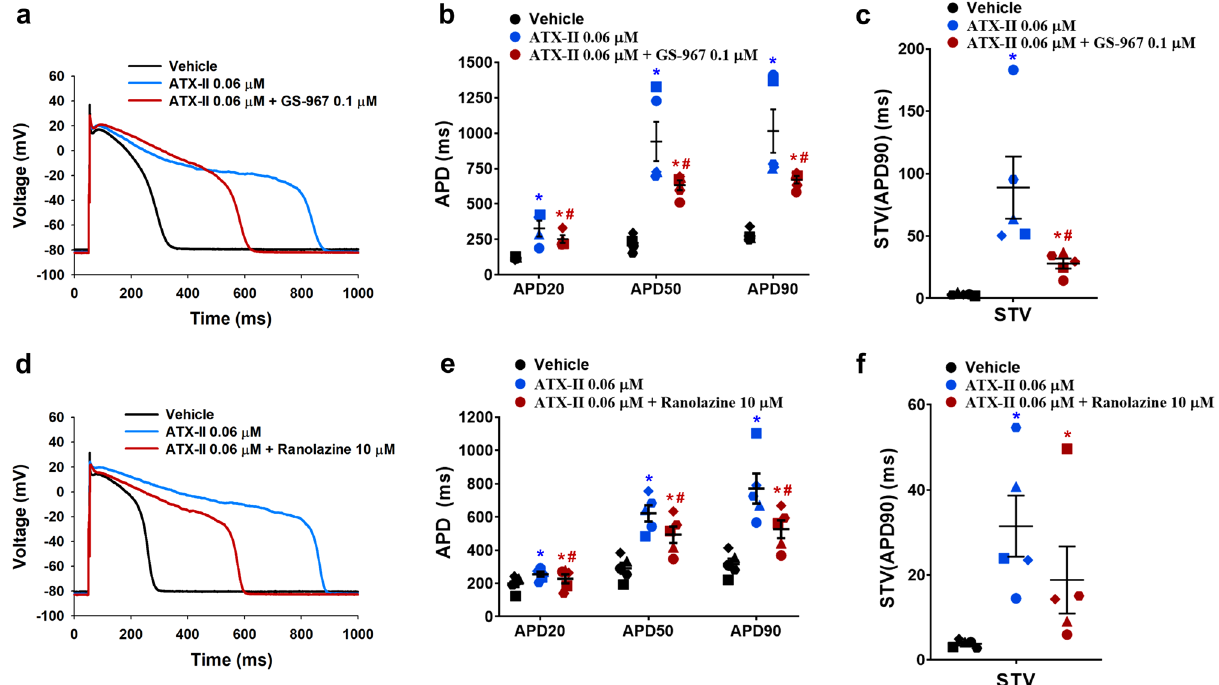
Figure 3. Effects of GS-967 and ranolazine on human ventricular action potential in condition mimicking LQTS3. ( a ) Typical action potentials (APs) recorded from a ventricular cell at a pacing of 1 Hz in the presence of vehicle control and after exposure to 0.06 µM ATX-II alone or in combination with 0.1 µM GS-967. ( b ) and ( c ) show mean % changes in APD (measured at 20% (APD20), 50% (APD50) and 90% (APD90) of